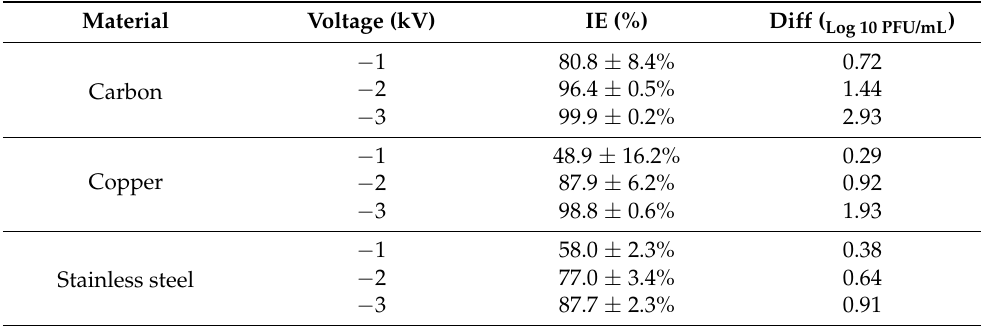
Table 2. Inactivation efficiencies (%) and logarithmic differences for the aerosolized MS2 bacterio- phages for each material and